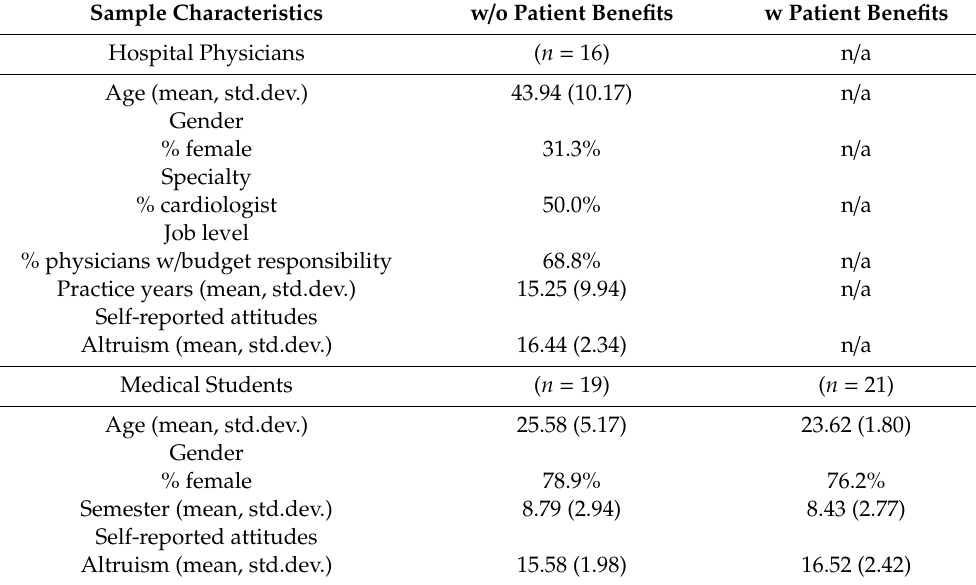
Table 2. Sample Characteristics for hospital physicians and medical